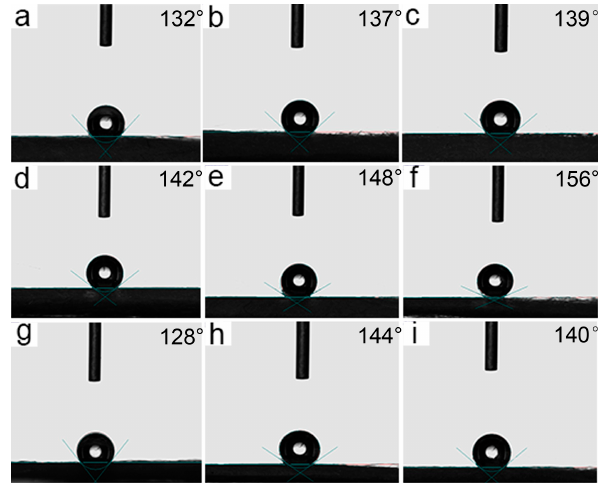
Figure 4. Contact angle images of melt electrospun fibers (( a – i ) (4% H201)/PLA, (4% H202)/PLA, (4% H203)/PLA, (8% H201)/PLA, (8% H202)/PLA, (8% H203)/PLA, (12% H201)/PLA, (12%